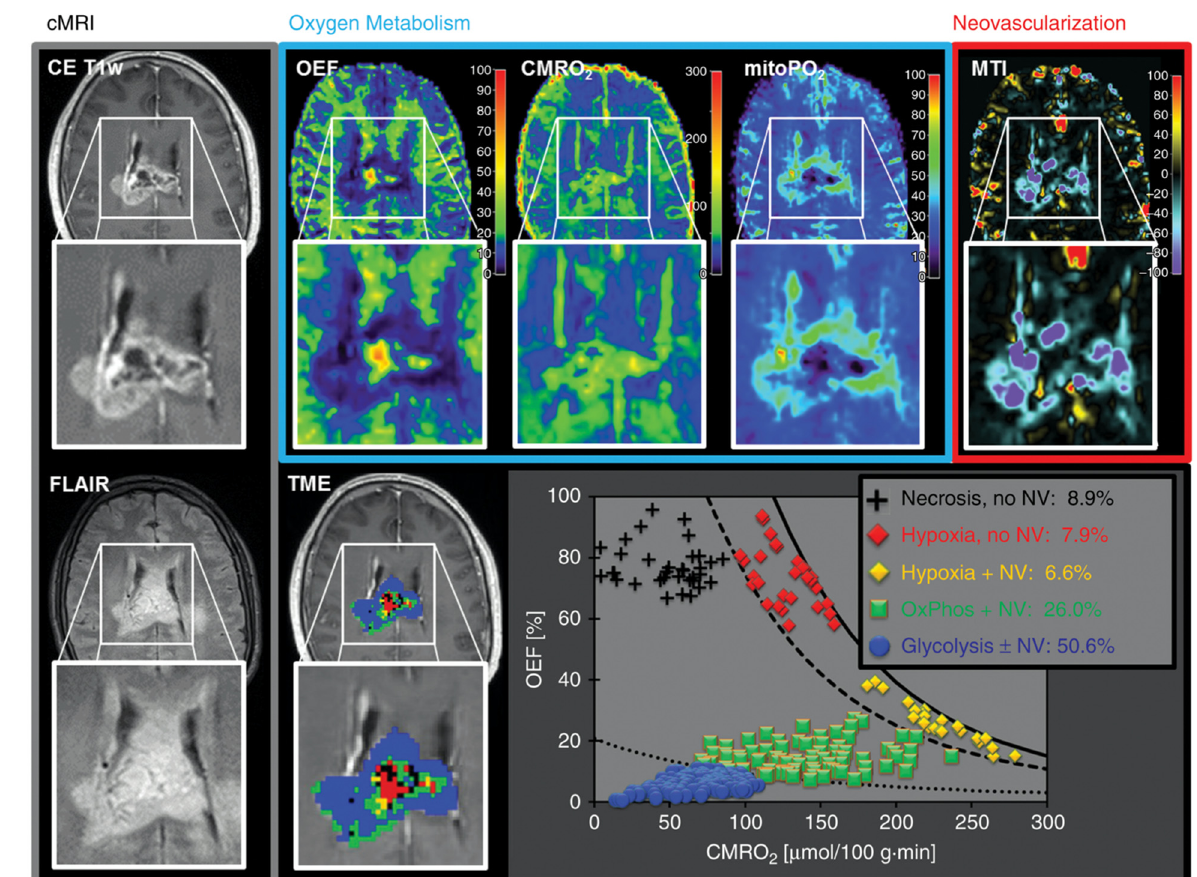
Figure 4. Clustering of tumor microenvironments (TMEs) in a IDH1 wt -glioblastoma (GBM). Maps representing advanced MRI (aMRI) markers of oxygen metabolism and neovascularization were calculated (upper row), and specific TMEs were identified on the basis of reciprocal variations of aMRI markers voxel-wise (lower row: TME map and scatter plot). According to glycolysis, hypoxia, and neovasculature markers, this GBM was classified as showing a “glycolytic-dominated” phenotype with functional neovasculature, a phenotype associated with better prognosis. Reproduced with permission from Stadlbauer et al. [132].